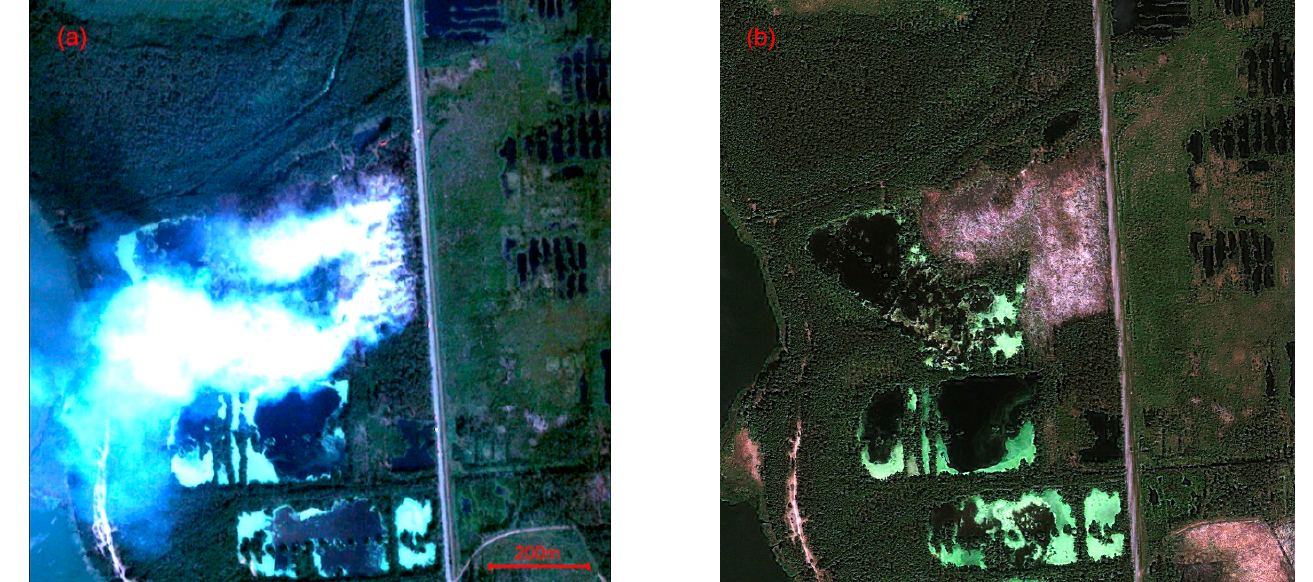
Figure 2. Active fire location, QuickBird image, 25 July 2010, © 2021 DigitalGlobe, Inc. ( a ); burned area with fallen trees on Ikonos image, 12 June 2011, © 2021 GeoEye, Inc., ( b ).